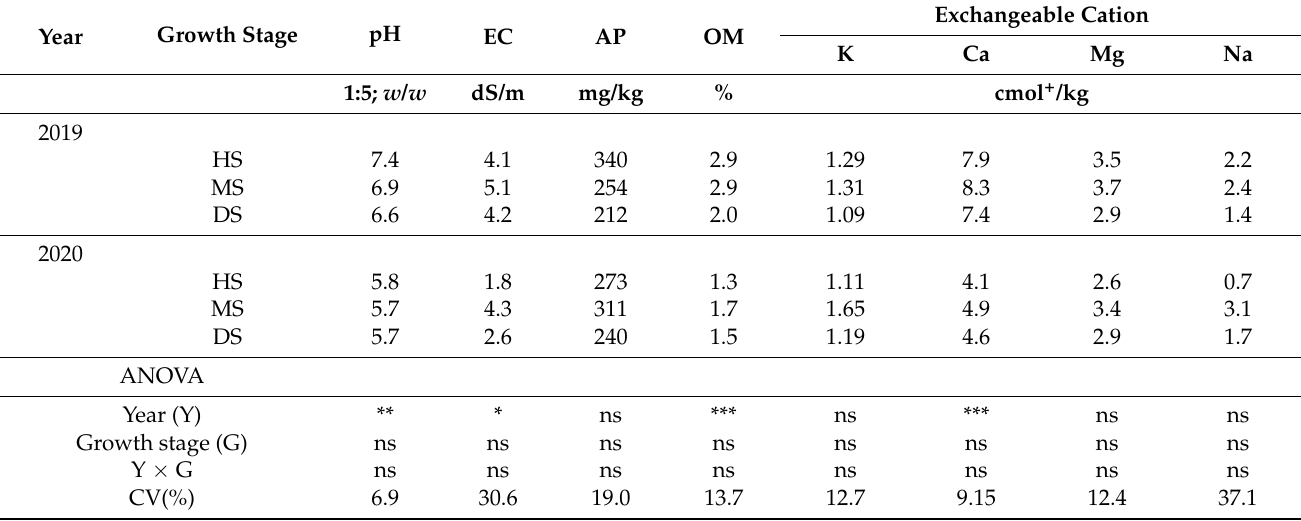
Table 3. The results of soil analysis according to the growth stage in reclaimed land soil for two years.